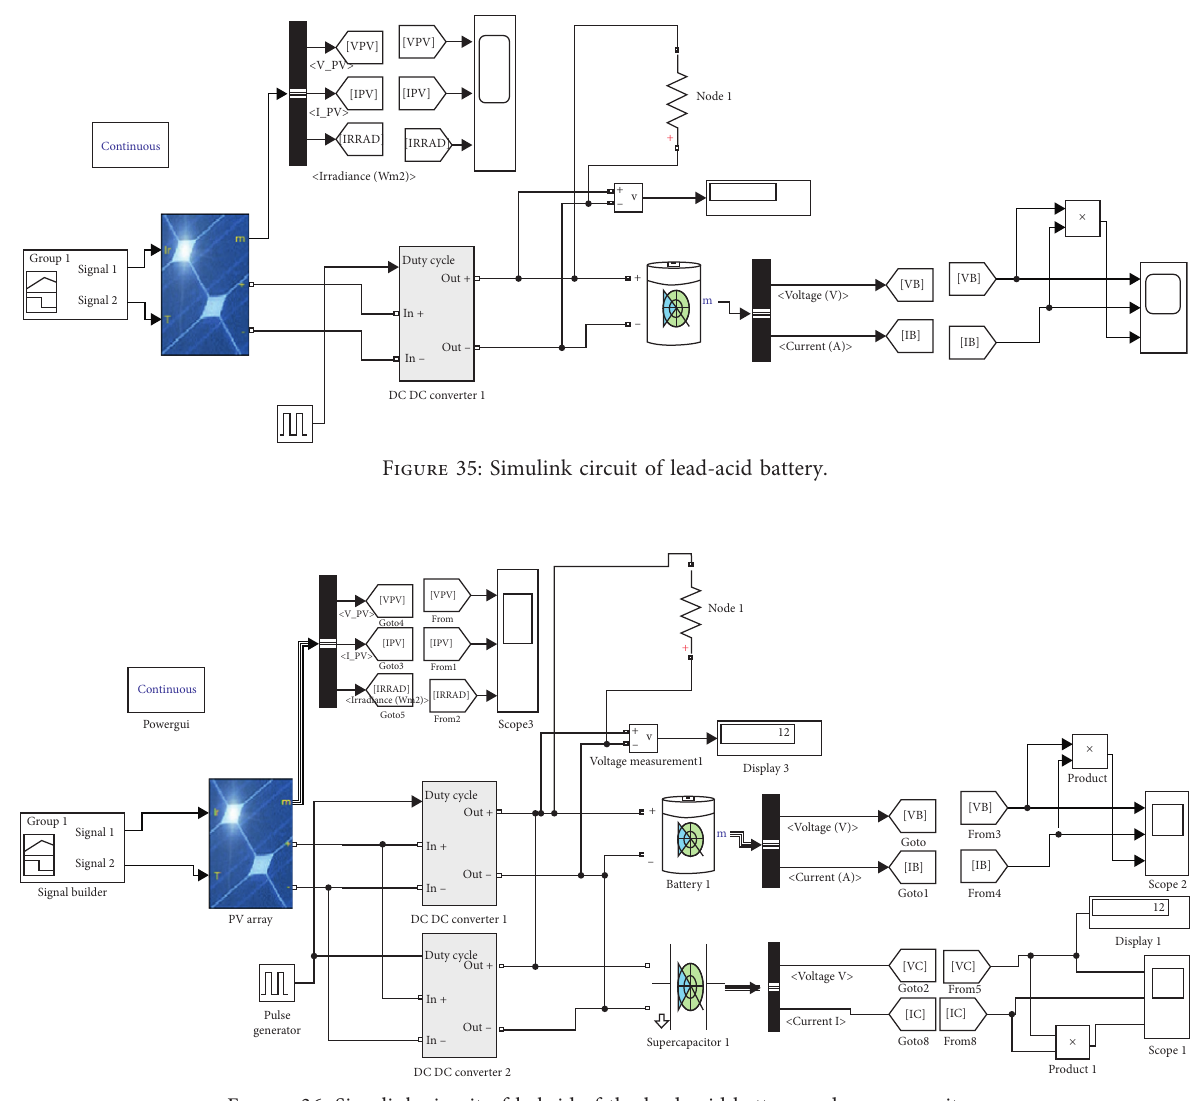
Figure 36: Simulink circuit of hybrid of the lead-acid battery and supercapacitor.